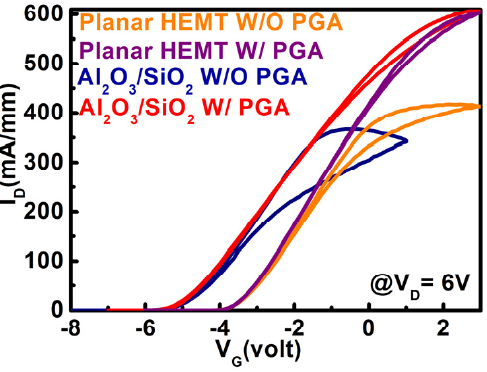
Figure 12. Hysteresis characteristics of the conventional HEMT and Al 2 O 3 /SiO 2 MOS–HEMT with and without PGA treatment.